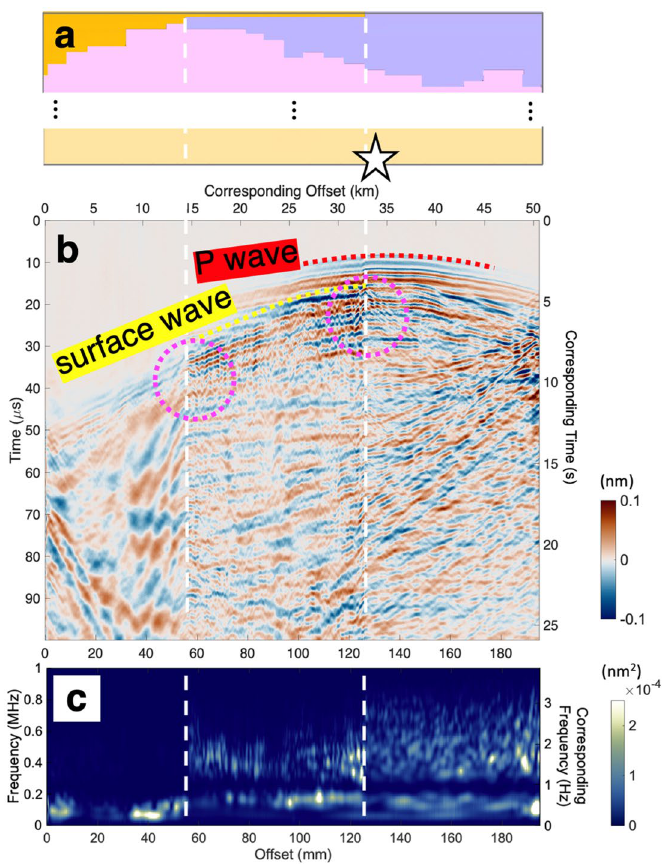
Figure 4. Seismic data obtained from the experiments with the source at depth. ( a ) The velocity model shown in Fig. 1b with the source location (white star). The two edges of the basins are marked with the dashed white lines. ( b ) Same as Fig. 3b except for the record section corresponds to the deep source shown in ( a ). P and surface waves are marked with dashed red and yellow lines, respectively. Waves scattered at the two basin edges (marked by dashed white lines) are highlighted with dashed magenta circles. An unlabeled version of the record section can be found in Supplementary Fig. S2. ( c ) Spectrum of each displacement time series in ( b ) at each offset shown in color. Two vertical axes are presented: frequencies in the experiments on the left and their corresponding frequencies in the actual